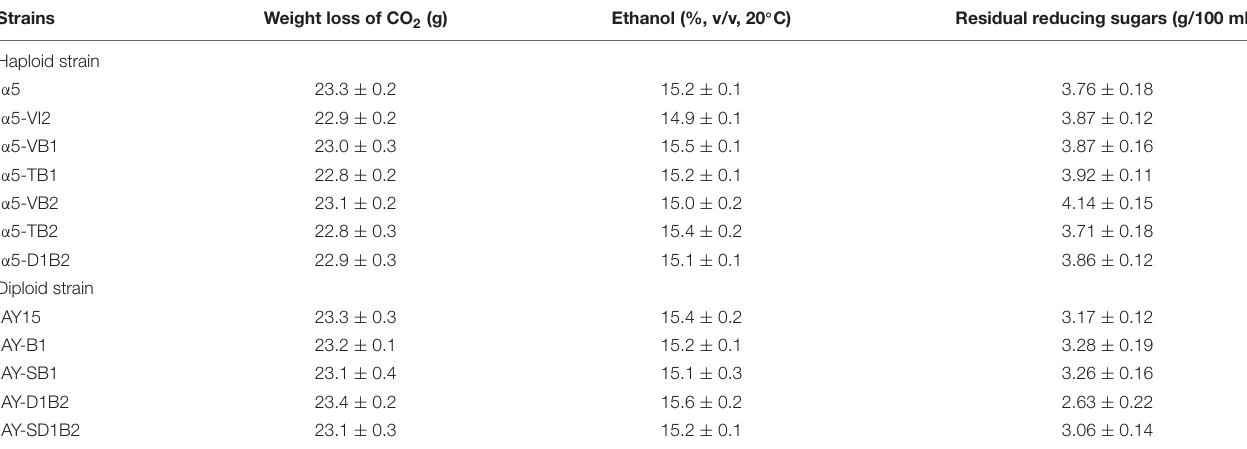
TABLE 3 | Fermentation Performances of recombinant